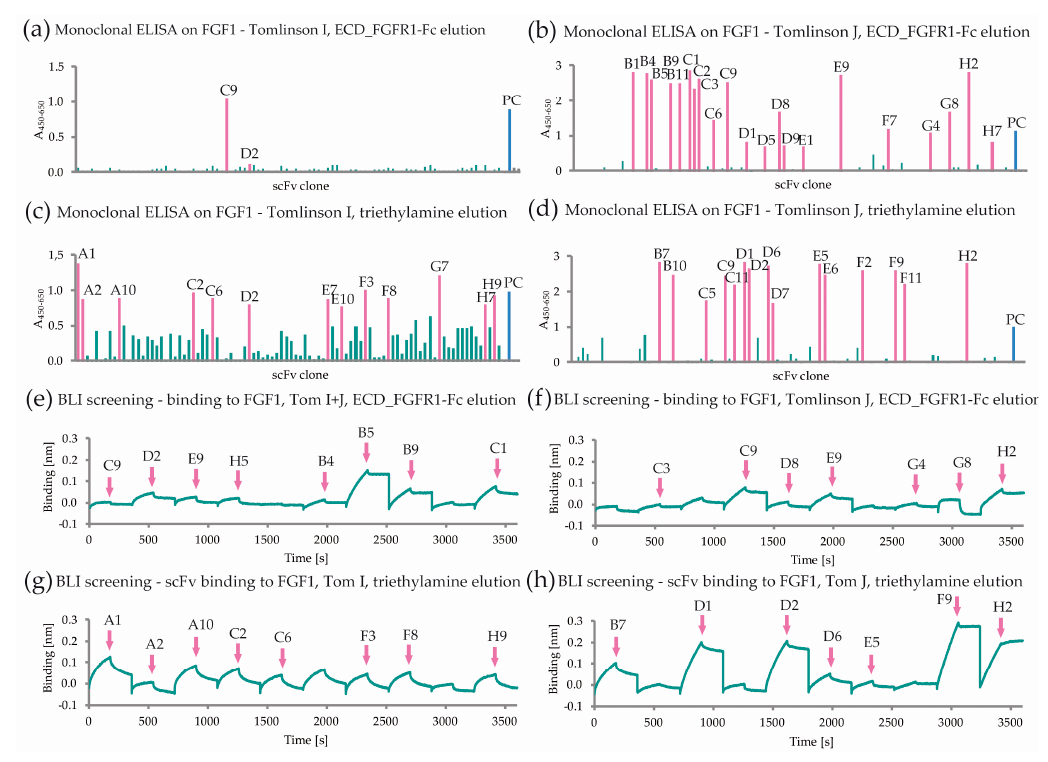
Figure 1. Analysis of anti-FGF1 scFv clones selected from Tomlinson I and J libraries. ( a , b ) ELISA signal (green) for the clones eluted using ECD_FGFR1-Fc and ( c , d ) triethylamine. Clones giving the highest signal (marked in pink) were selected for further analysis. Anti-BSA clone (PC, indicated in blue) served as a positive control. Grey bars represent negative controls; and ( e – h ) BLI screening of scFv clones bacterial supernatants against FGF1 immobilized on the sensor surface (binding signal shown in green). Clones with the best binding profiles (indicated with pink arrow) were chosen for further testing. All scFv names originate from the 96-well plate location of the picked clone.